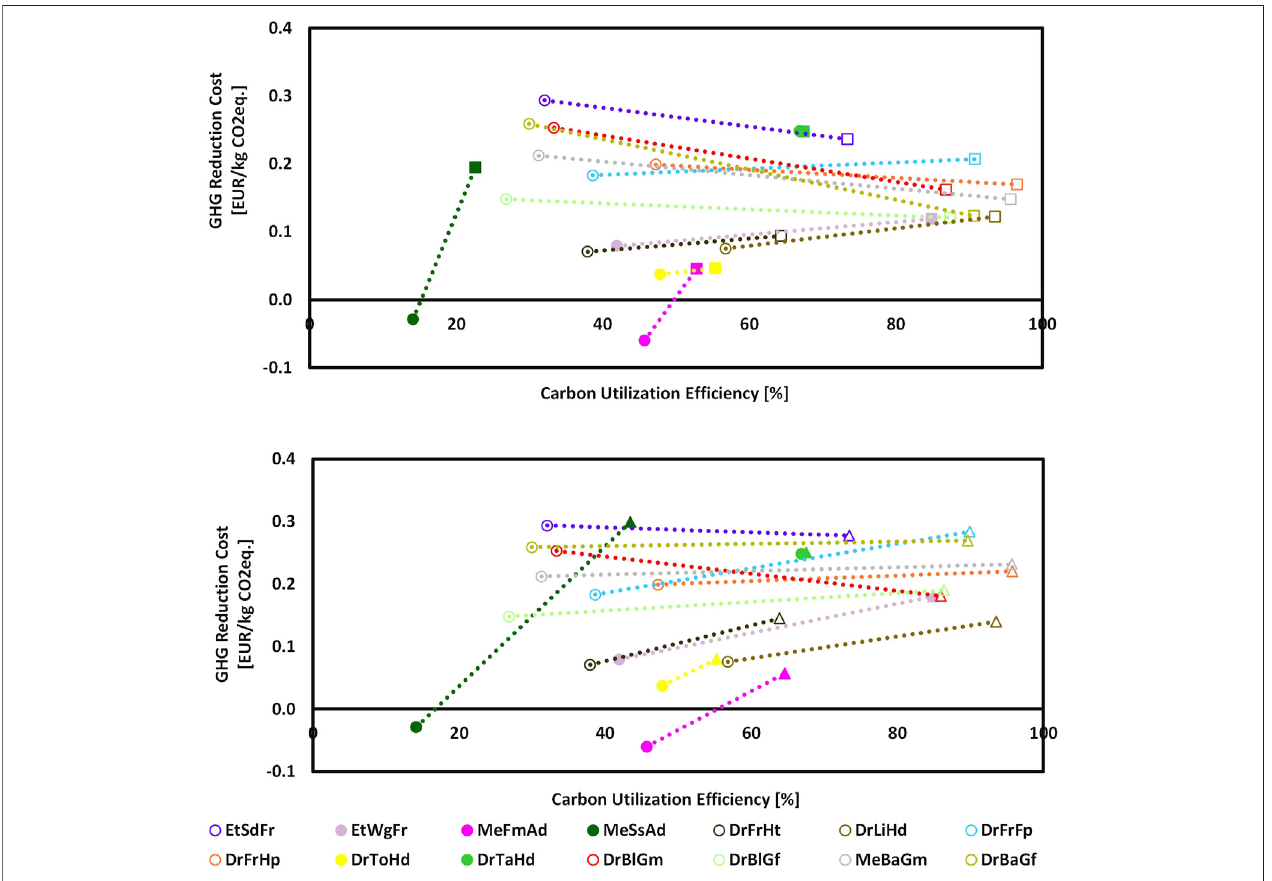
FIGURE7| Costofreducing1 kgCO 2 eqofgreenhousegasemissionswitheachpathwayunderthebase(circle),carboncaptureandstorage(CCS)(square,top), and carbon capture and utilization (CCU) (triangle, bottom) options. Empty markers represent emerging pathways and fi lled markers represent commercial pathways.